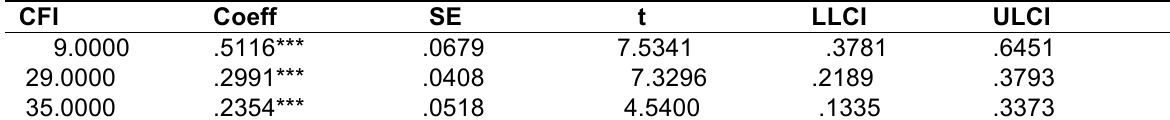
Table 7: Conditional effects of the focal predictor at values of the moderator